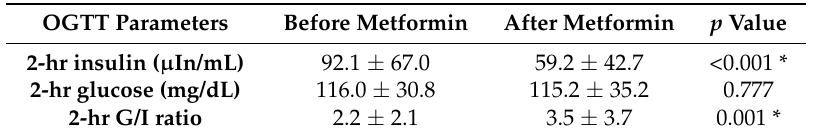
Table 2. Oral glucose tolerance test (OGTT) parameters in all women with PCOS before and after metformin treatment. OGTT Parameters Before Metformin After Metformin p Value 2-hr insulin ( µ In/mL) 92.1 ±